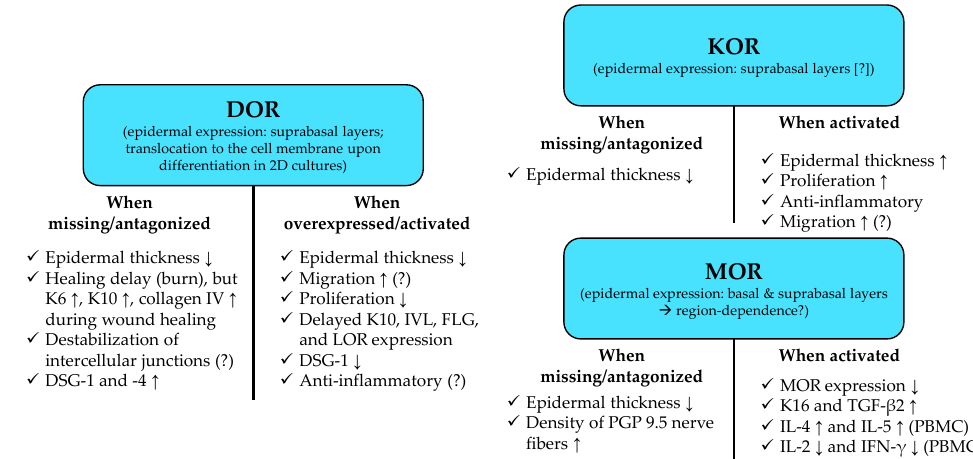
Figure 3. Overview of the expression patterns and “AD-relevant” roles of the major opioid receptors in human epidermal keratinocytes and PBMCs. DOR, KOR, and MOR are involved in the regulation of the proliferation/differentiation balance of the epidermal keratinocytes, as well as in influencing immune responses. (Question marks indicate conflicting data/unclear effects.)